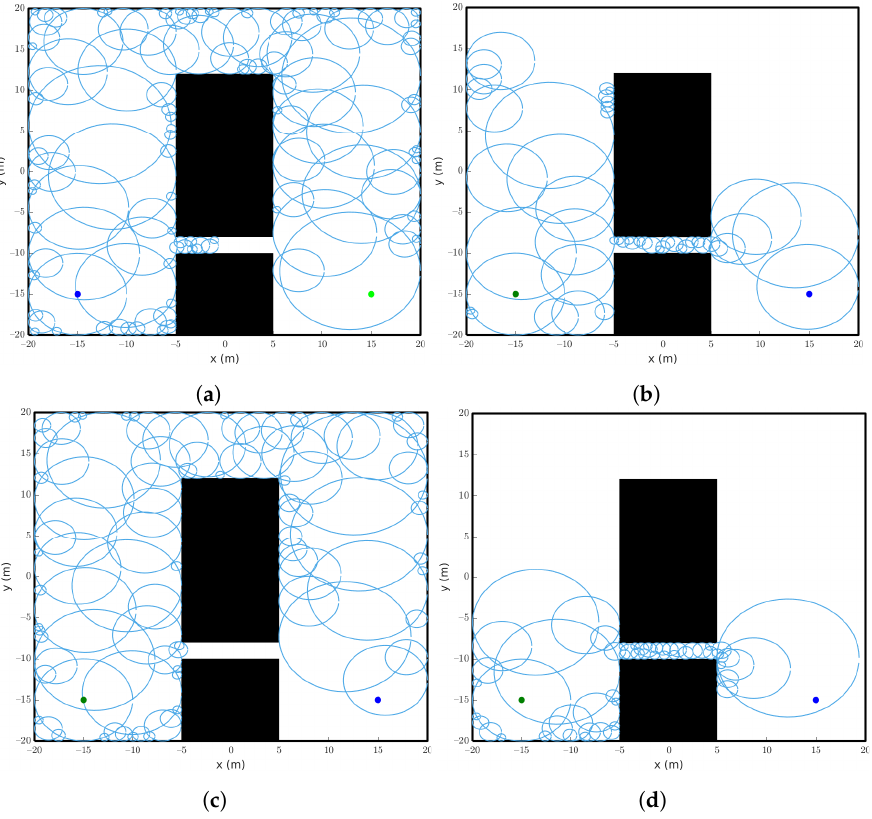
Figure 9. Probabilistic foam generated by the simulations for Map 2 with the algorithms ( a ) PFM, ( b ) GBPF, ( c ) RBPF, and ( d )